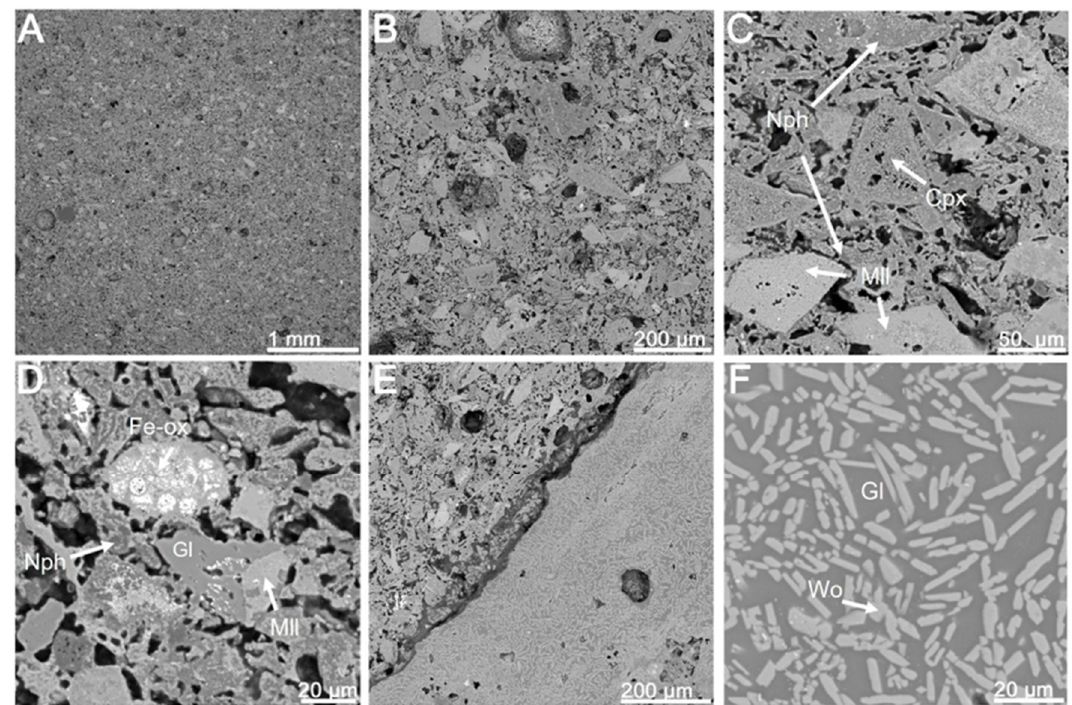
Figure 4. SEM images (BSE mode) of the CFM specimen, showing both microstructure and phase assemblage. ( A ): Large view. ( B ): Magnification of the area in ( A ) with distribution of pseudomorphic phases within an interconnected micro-porosity pattern. ( C ): Detail of aggregates unevenly composed of melilite, clinopyroxenes and nepheline. ( D ): Detail of an aggregate mainly composed of Fe- oxides and distribution of melilite, nepheline and also portions of silicate glass. ( E ): To the left, the same microstructure shown in ( A – C ). To the right, an area with glass and elongated skeletal wollastonite micro-crystals (enlarged view in ( F )). Abbreviations: Cpx = clinopyroxene; Mll = melilite; Nph = nepheline; Gl = glass; Fe-ox: Fe-oxides.